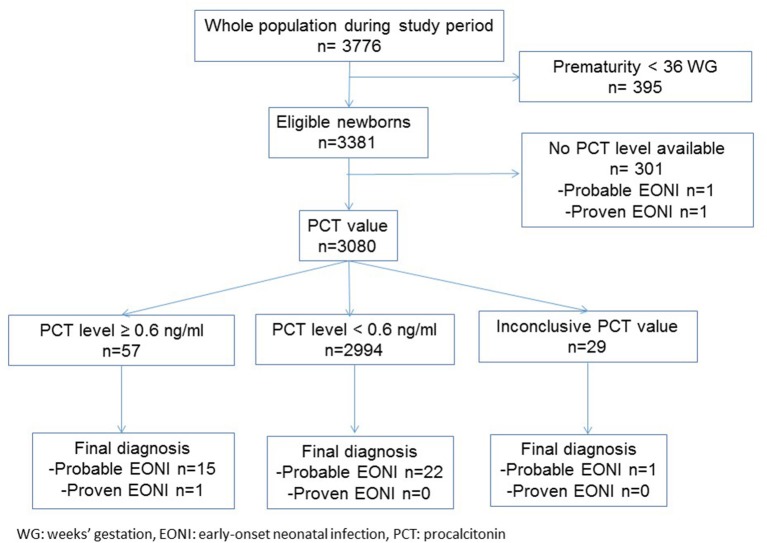
Flowchart of newborns in the study.